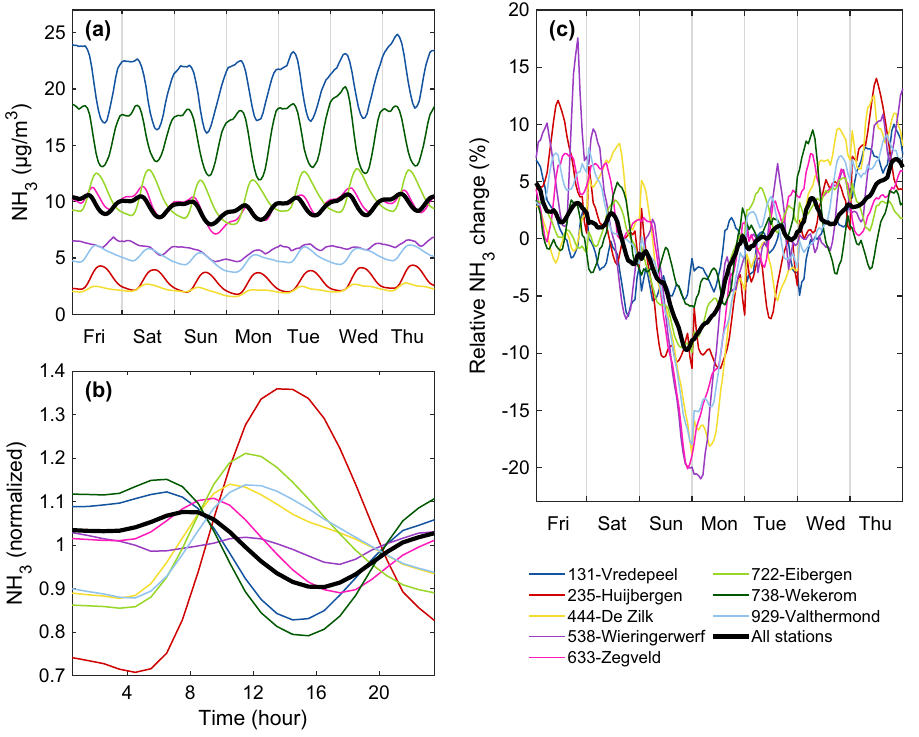
− 3 ) for each individual site (coloured lines) from